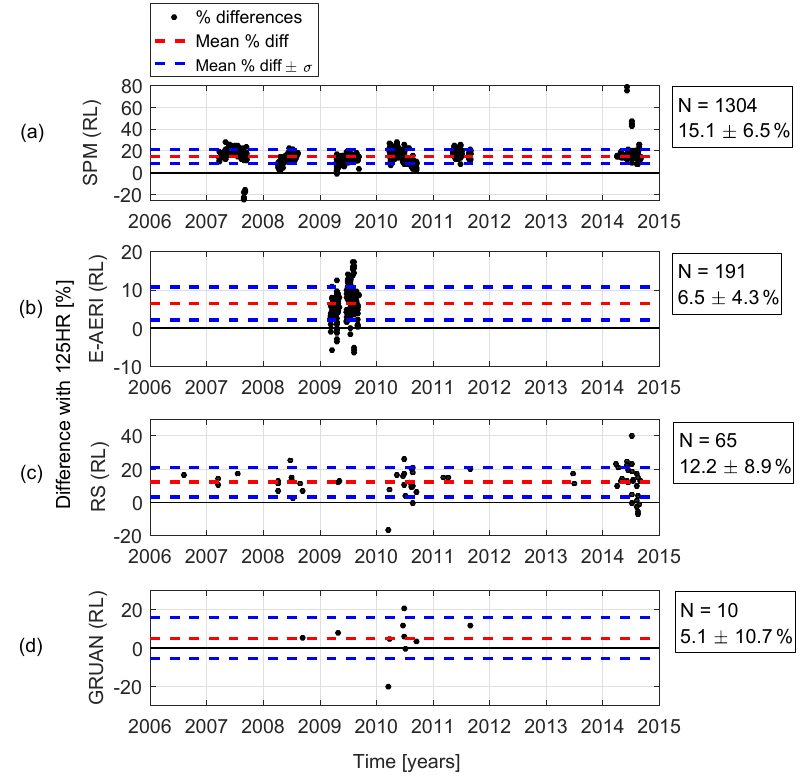
Figure 8. Comparisons of the 125HR water vapour with PEARL Ridge Lab and Eureka Weather Station instruments. (In Eq. 2, X is 125HR and Y is comparison instrument). The red lines denote the mean difference, while blue lines denote 1 standard deviation above and below the mean difference. The number of comparison pairs and the mean percent difference and standard deviation are noted for each